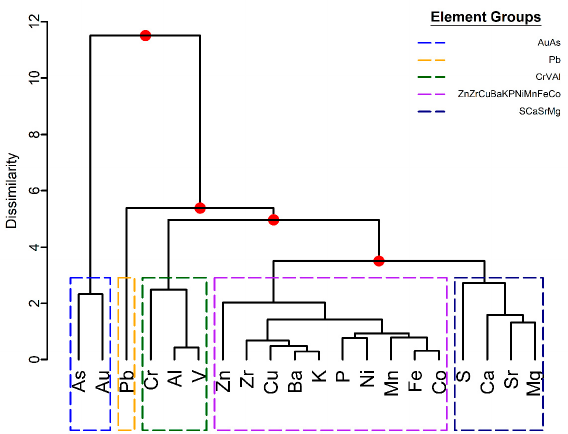
Figure 7. Dendrogram after hierarchical clustering the variation matrix of a 20-element geochemical subcomposition analyzed in weathered and fresh rock observations. Red points indicate the cluster splits. Codependence among variables decreases from the bottom to the top of the diagram. The top of the colored boxes corresponds to the dissimilarity at which clusters of elements are taken to create composite variables. The variation matrix is available in Appendix A Table A1.